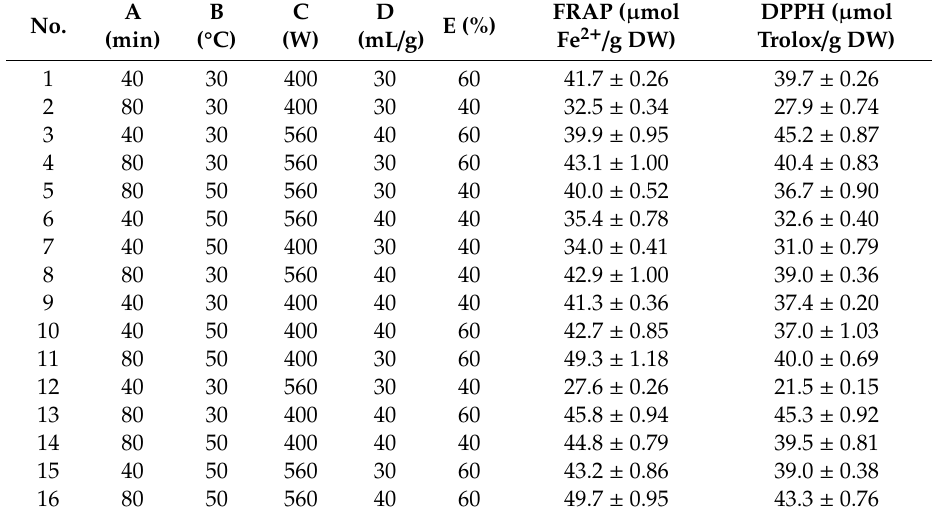
Table 2. Experimental design and results of design of